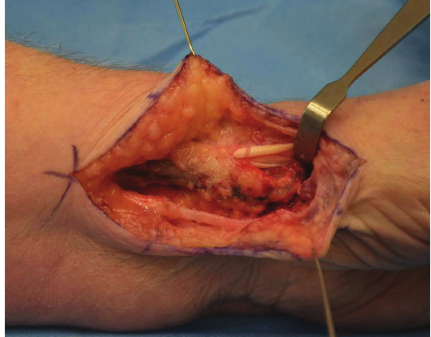
Figure 3: APL and EPB retracted. Radial artery seen inferior to the